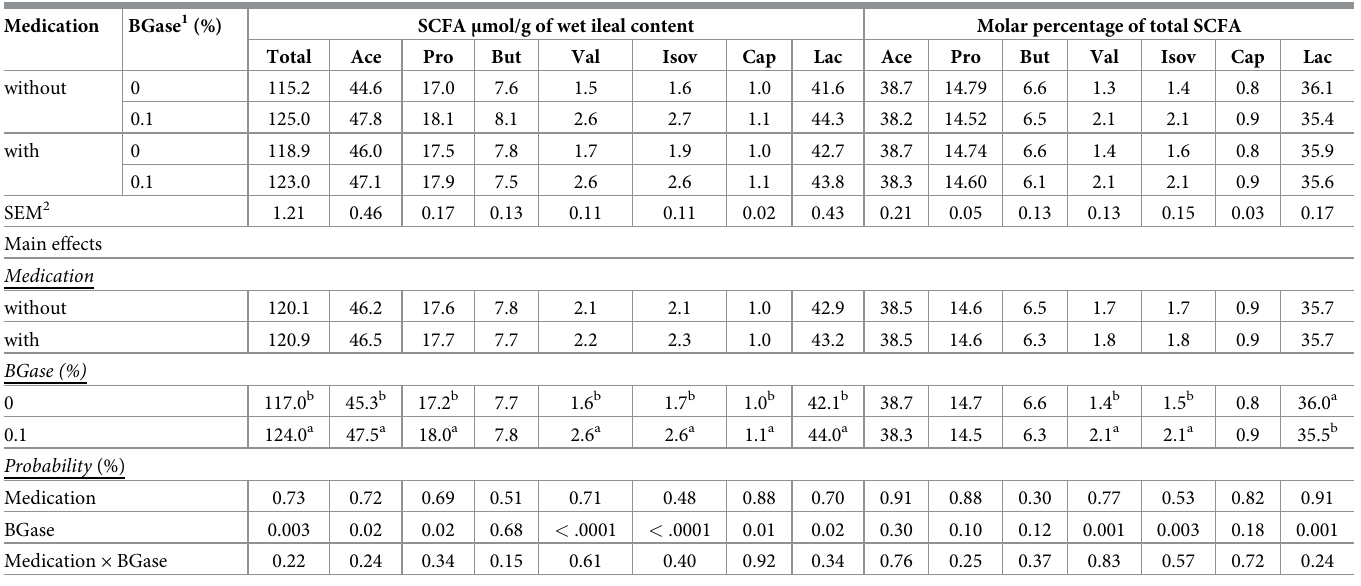
Table 12. Effects of diet medication and β -glucanase on ileal short chain fatty acids of broiler chickens aged 33 days (Experiment 2). Medication BGase 1